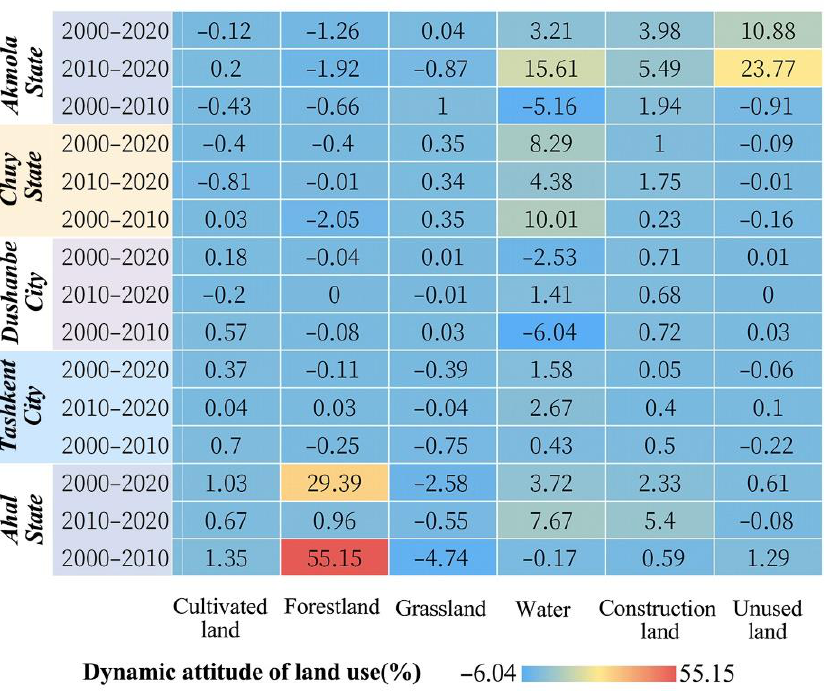
Figure 6. The main transfer relationship between land use types. From 2000 to 2020, the area of grassland transferred out in Akmola State was the largest, and the area converted into cultivated land accounted for 49.49% of the total area